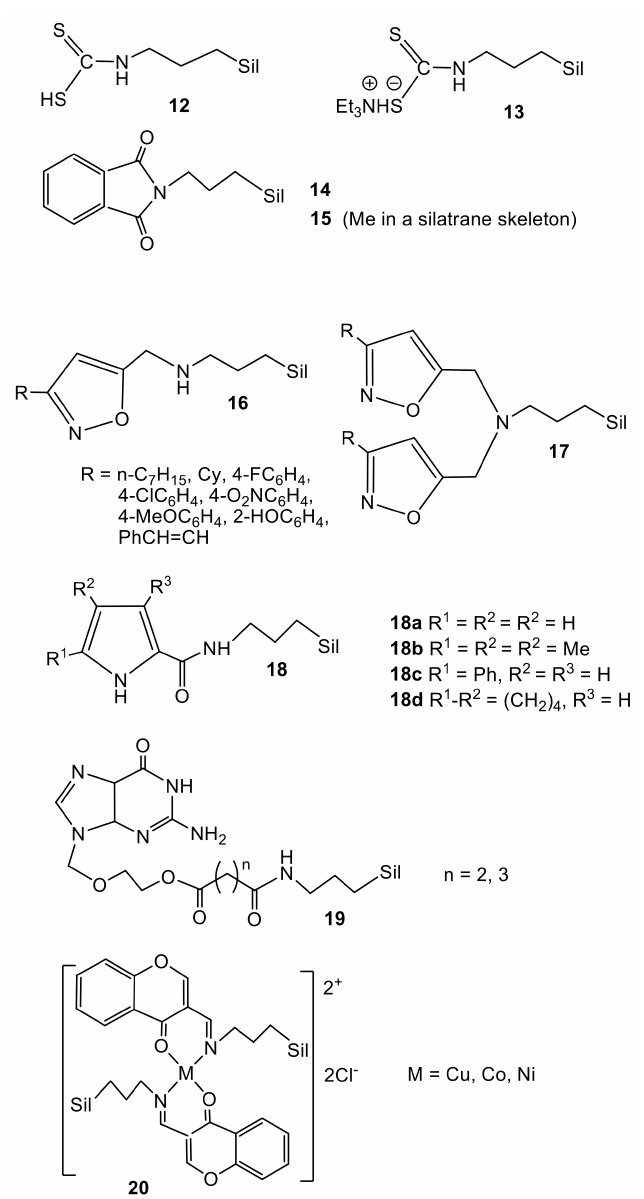
Figure 5. Chemical structures of silatranyl antimicrobial agents ( 12 – 20 ). APS ( 1 ) and 2-(trichloroacetyl)pyrroles were used as precursors to obtain hitherto unknown 1 H -R-pyrrole-2-carboxamidesilatrane hybrids ( 18 ) (Figure 5) [52]. The